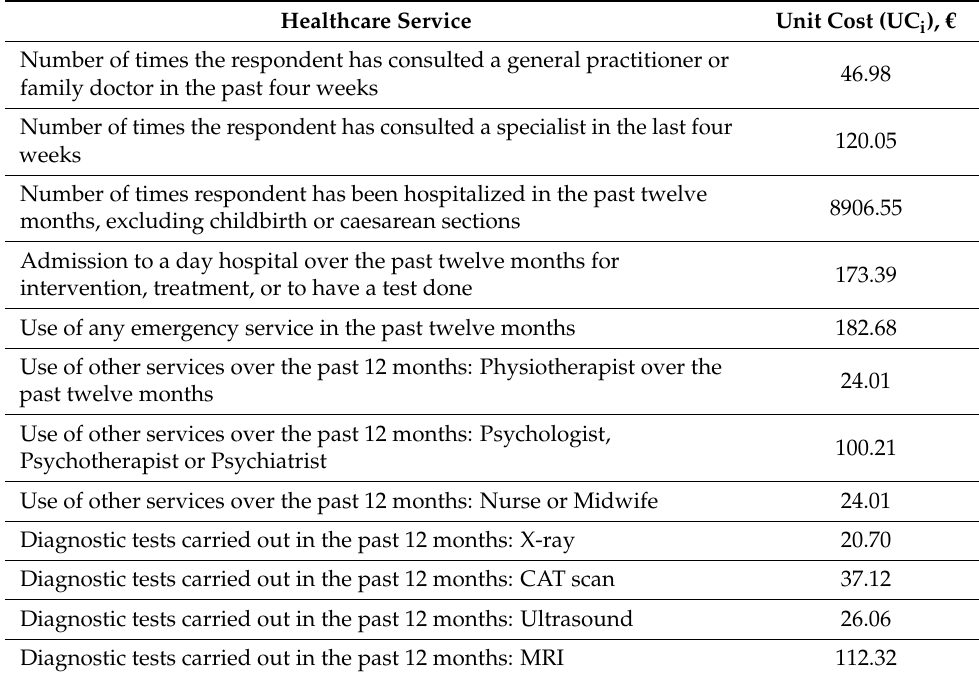
Table 2. Unit costs of healthcare